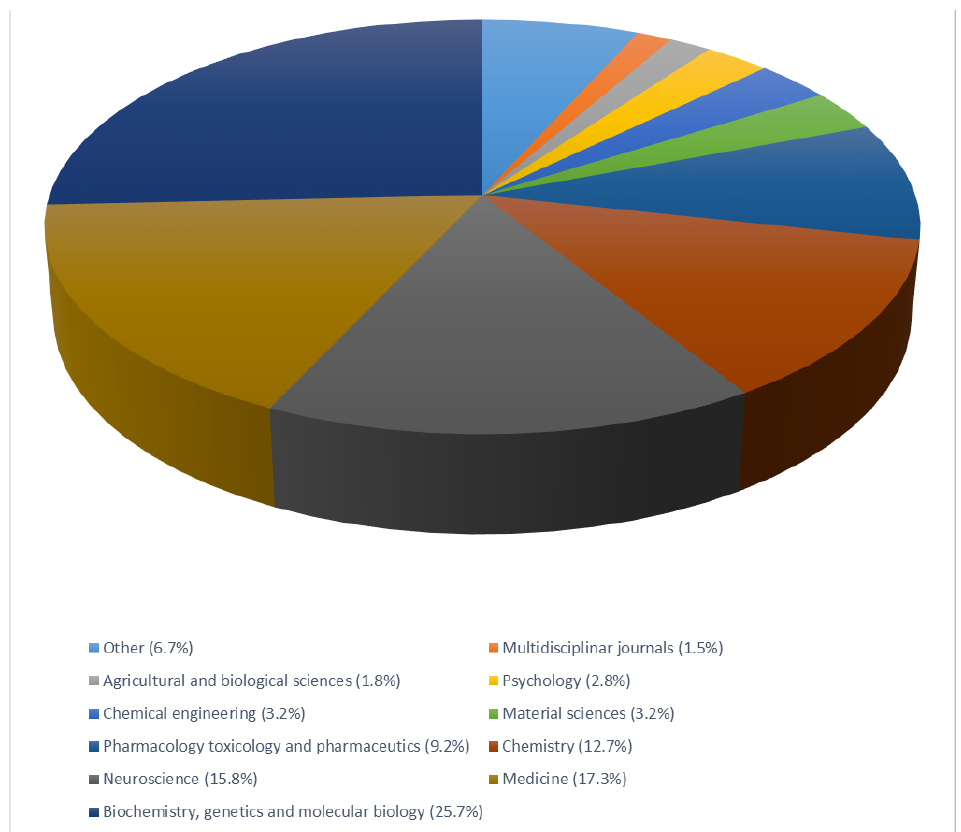
Figure 1. Pie chart illustrating the literature published on the topic ‘Copper’ and “Alzheimer’s disease”. Search on the Scopus research engine retrieved 3009 scientific articles; the stratification by ‘subject area’ reveals that 25.7% of the papers published come from the Biochemistry area, 17.3% from Medicine, 15.8% from Neuroscience, 12.7% from Chemistry and 9.2% from